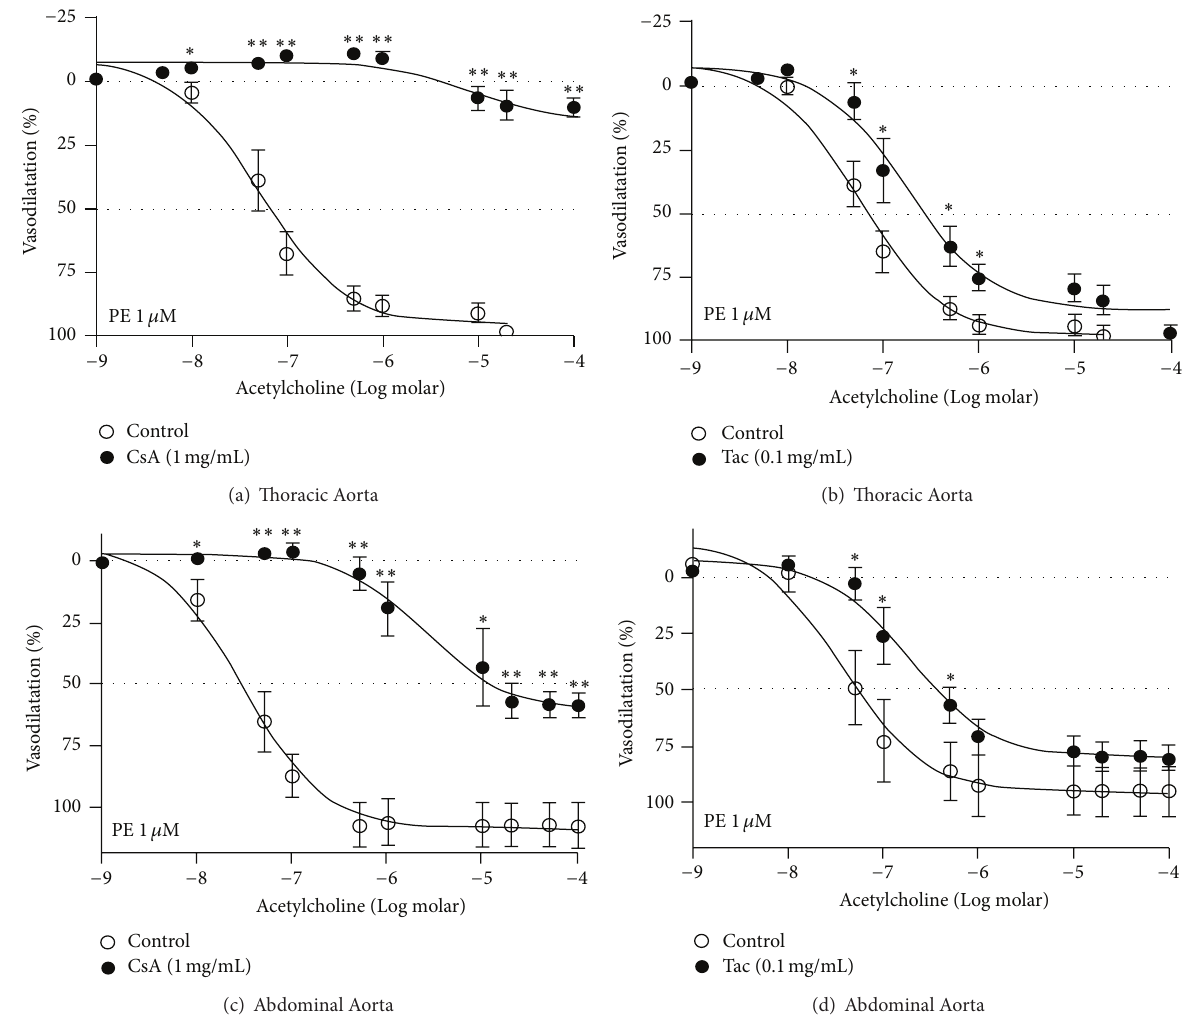
Figure 1: The panel compares the concentration-inhibition response curves (CRC) to acetylcholine (ACh) determined in phenylephrine (PE—1 𝜇 M)-constricted thoracic ((a) and (b) panels) and abdominal ((c) and (d) panels) aortic rings with intact endothelium either in the presence or absence of cyclosporine (CsA—1mg/mL) or tacrolimus (Tac—0.1mg/mL) maintained in the incubation medium for a period of 30 min after isolation from 13-week-old male Sprague Dawley rats ( 𝑛 = 6 ). ∗ 𝑃 < 0.05 and ∗∗ 𝑃 < 0.01 compared to respective data in the control